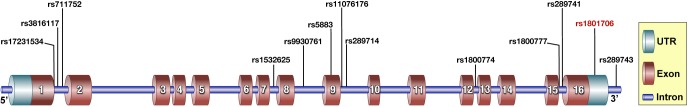
Observed variations and its location in CETP gene.mRNA.ENST00000200676 was utilized to represent the physical location of variants.